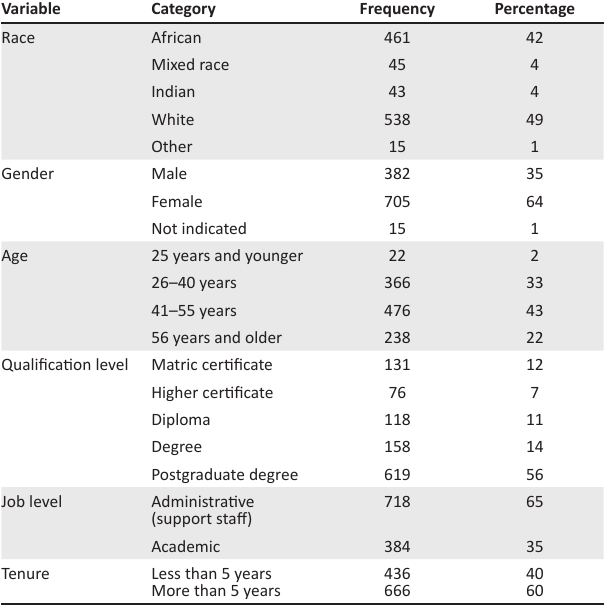
TABLE 1: Sociodemographic characteristics of the participants.